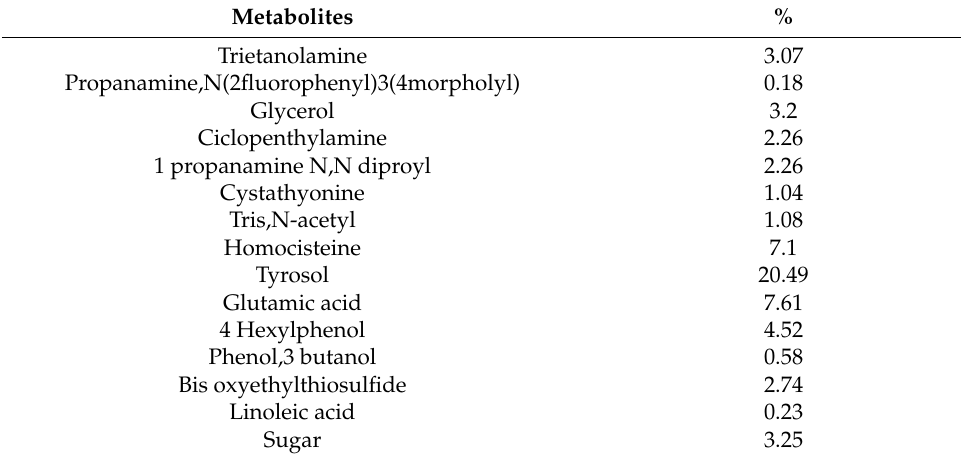
Table 9. List of identified metabolites (expressed in percentage) recognized in the fifth OP-F sample by GCMS